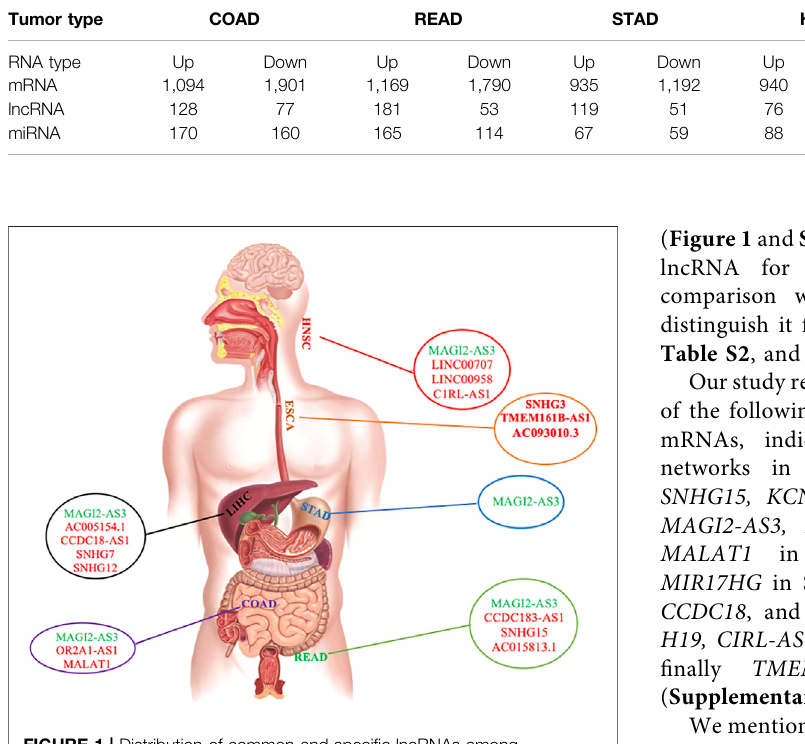
FIGURE 1 | Distribution of common and speci fi c lncRNAs among different GI cancers. lncRNA in green color is the common one among GI cancers. lncRNAs in red are speci fi c in each GI cancer. The gastrointestinal tract shown in this fi gure was reproduced from an image